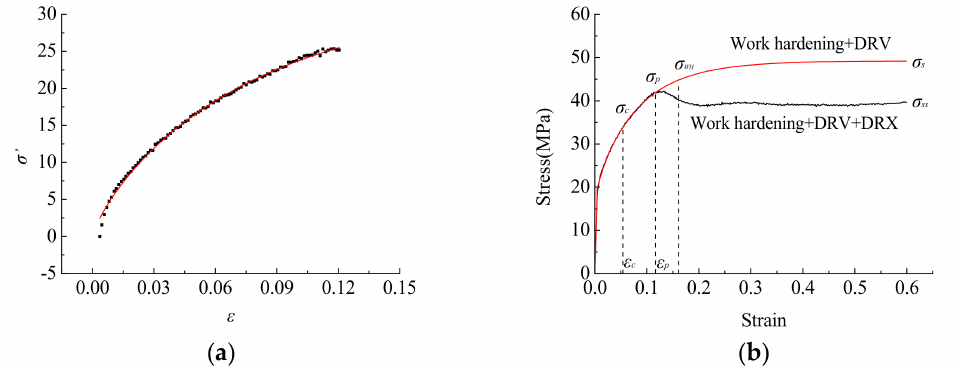
Figure 7. Dynamic recovery and dynamic recrystallization curve. ( a ) Dynamic recovery curve; ( b ) Dynamic recrystallization curve.